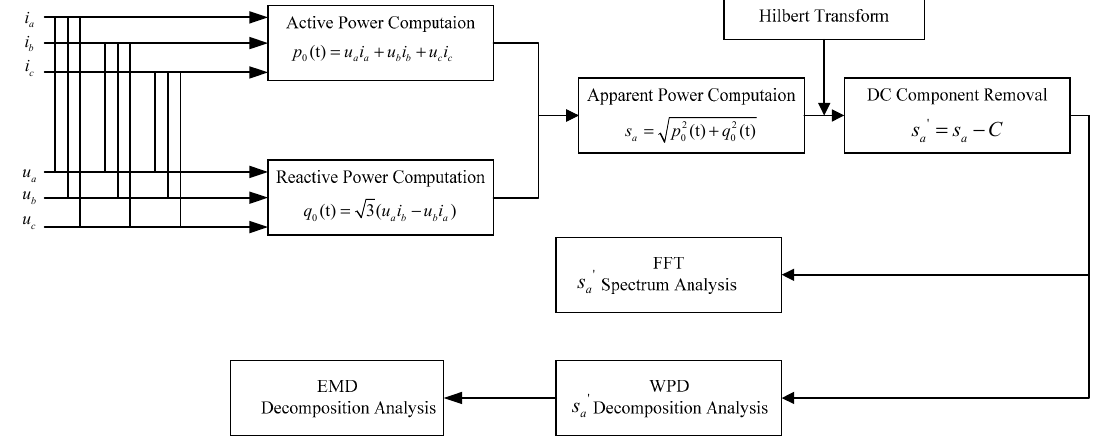
Figure 8. The computation of apparent power analysis scheme.